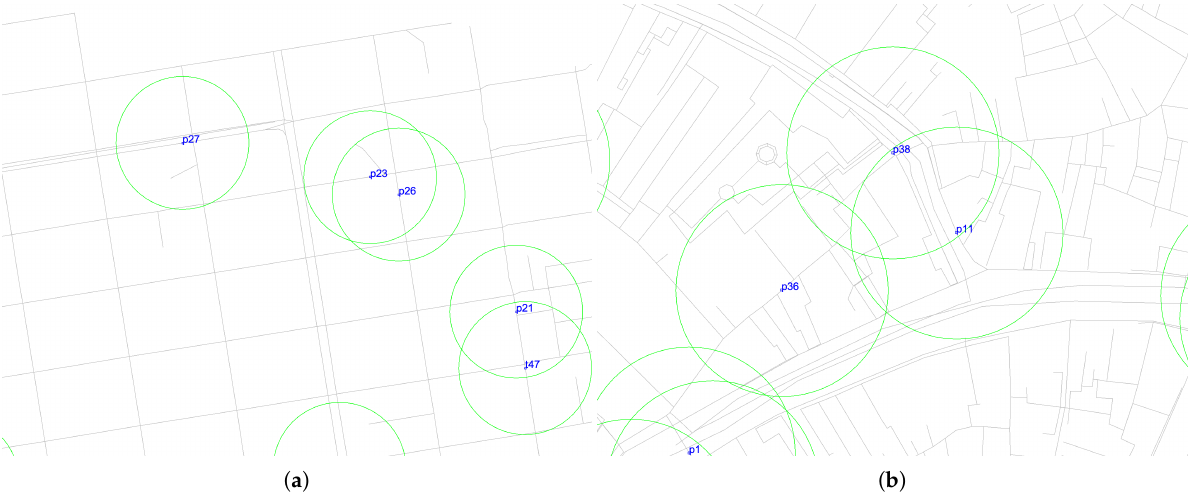
Figure 3. The city structures of San Francisco and Venice. ( a ) San Francisco; ( b ) Venice.